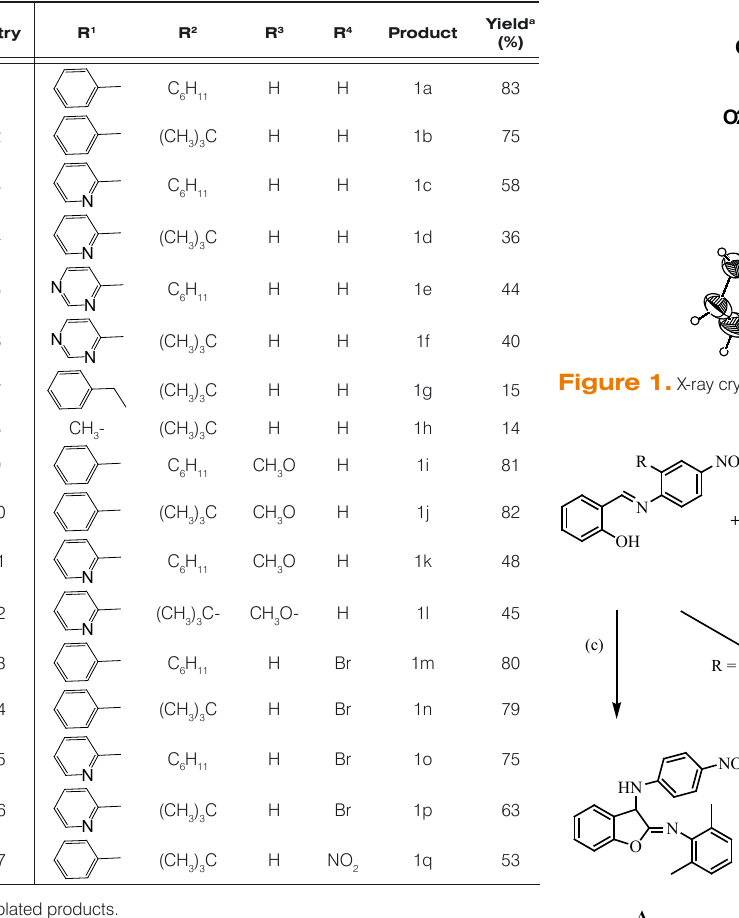
Table 1. Results of the synthesized 1a-q